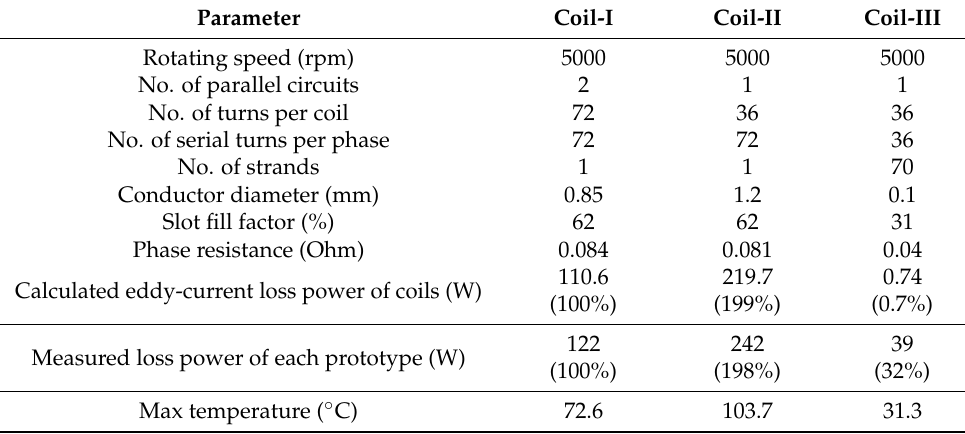
Table 4. Comparison of no-load characteristics for the three stator models.